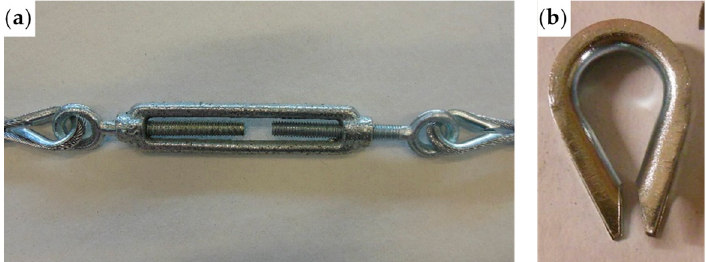
Figure 12. The fastening system of the second combined technique: ( a ) Two Flemish eyes connected by an eye–eye turnbuckle and ( b ) detail of the thimble placed inside a Flemish